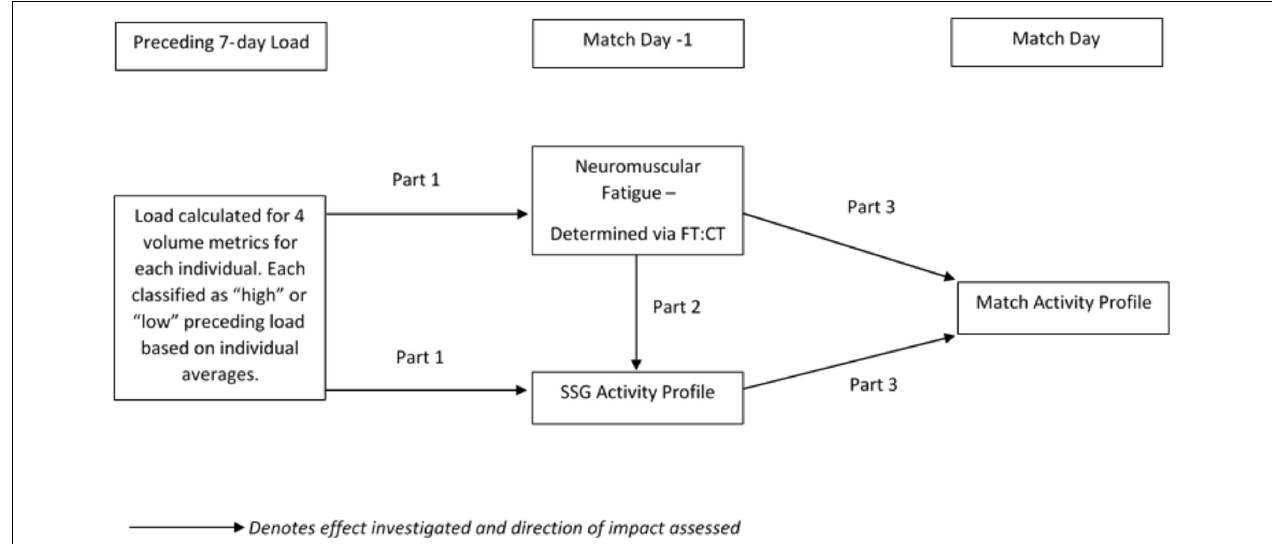
FIGURE 1 | Diagrammatic representation of the steps of analysis. Small-sided game; SSG, Flight time:Contraction time ratio;